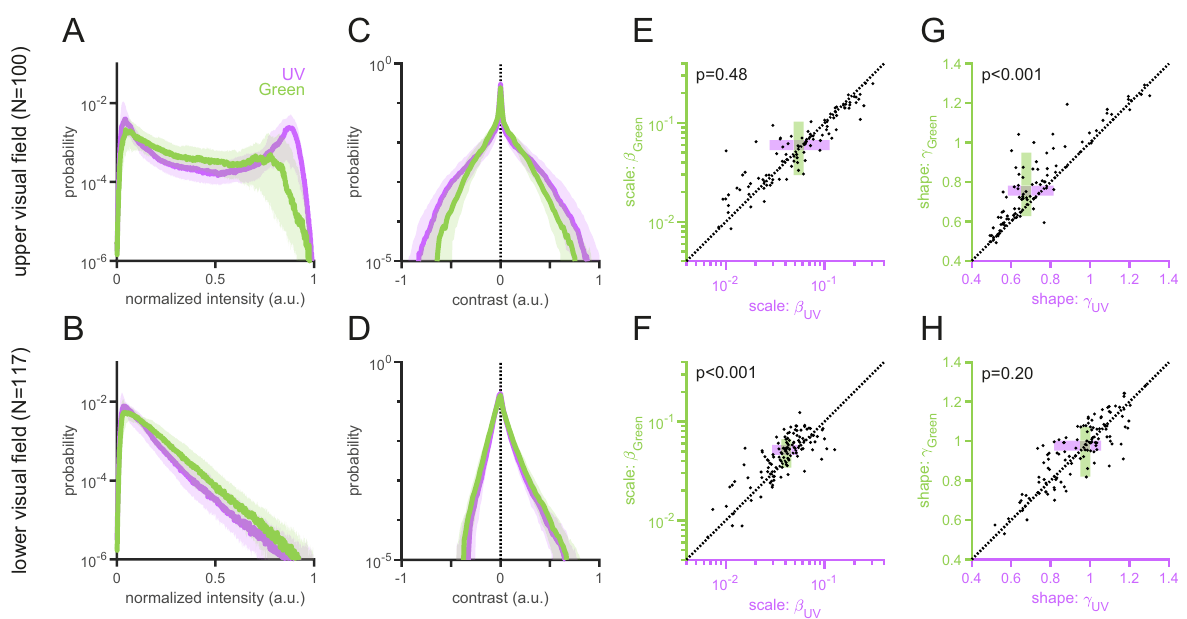
Fig 3. Light intensity and local contrast distributions of the “mouse-view” natural images. (A,B) Normalized light intensity distributions of the upper (A) and lower (B) visual field images for UV (violet) and Green (green) channels (median and interquartile range). (C,D) Local contrast distributions computed with the Laplacian-of-Gaussian filter ( σ = 10 in Eq (2); see S3 Fig for the distributions computed with different σ values). The distribution of the UV channel is more strongly heavy-tailed than that of the Green channel for the upper visual field images (C), but the Green channel’s distribution is wider than the UV channel’s for the lower visual field images (D). (E–H) Scale ( β ; E,F) and shape ( γ ; G,H) parameters from the Weibull distribution fitted to each image (Eq (3); see Methods for details). For the upper field images (E,G), the UV channel has significantly smaller γ (G) but comparable β (E) values than the Green channel. In contrast, for the lower field images (F,H), the Green channel has significantly larger β (F) but comparable γ (H) values than the UV channel. P -values are obtained from sign-tests.